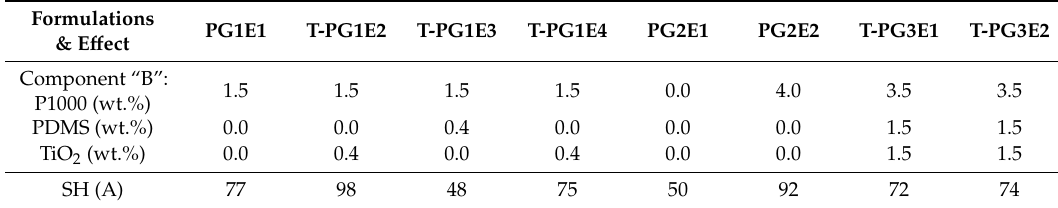
Table 6. Values of surface hardness.